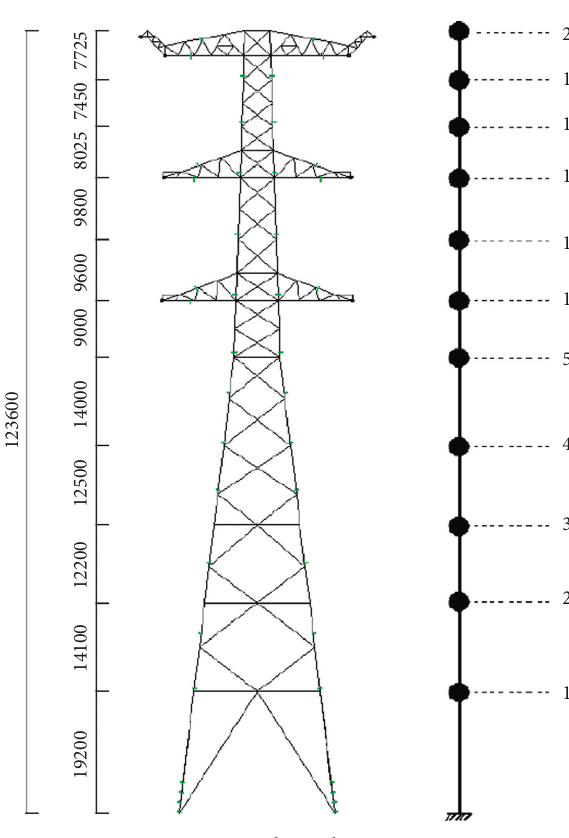
Figure 4: Wind simulation